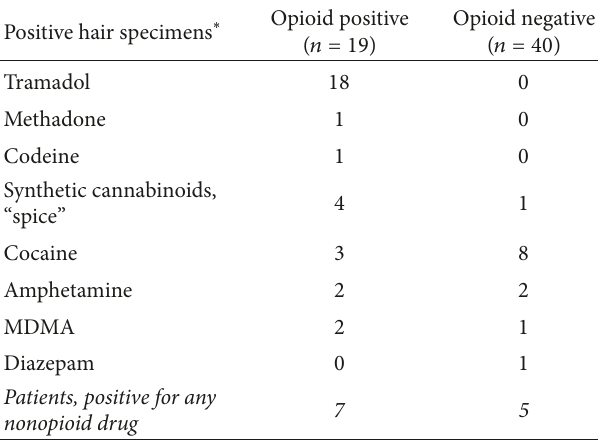
Table 2: Positive hair specimens in opioid positive and opioid negative patients, 𝑁 = 59 (excluding nonsynthetic